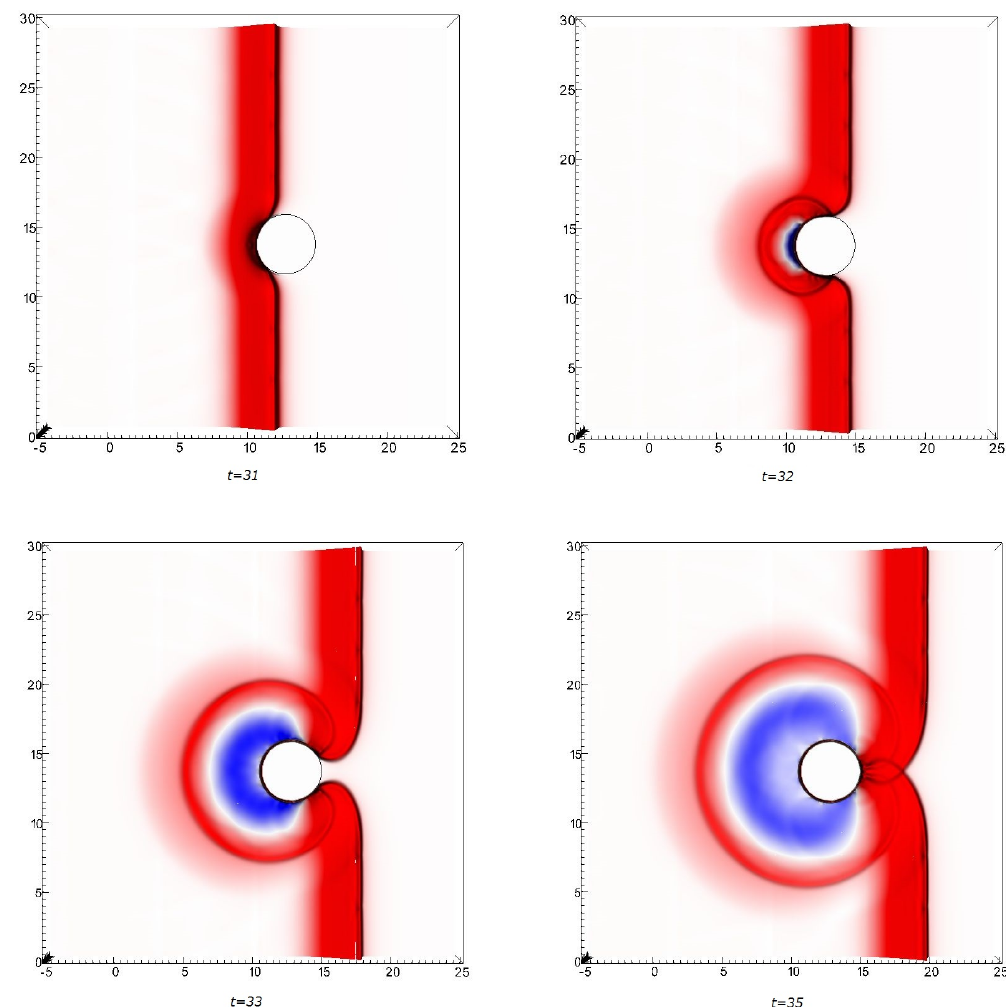
Figure A6. Snapshots at several times showing the wave front splitting in front of the island and colliding behind it for case